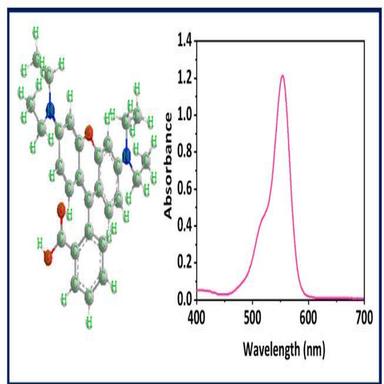
3D Formula and UV–vis spectrum of a solution of RhB (C28H31ClN2O3, Mass weight: 479.02 g/mol).